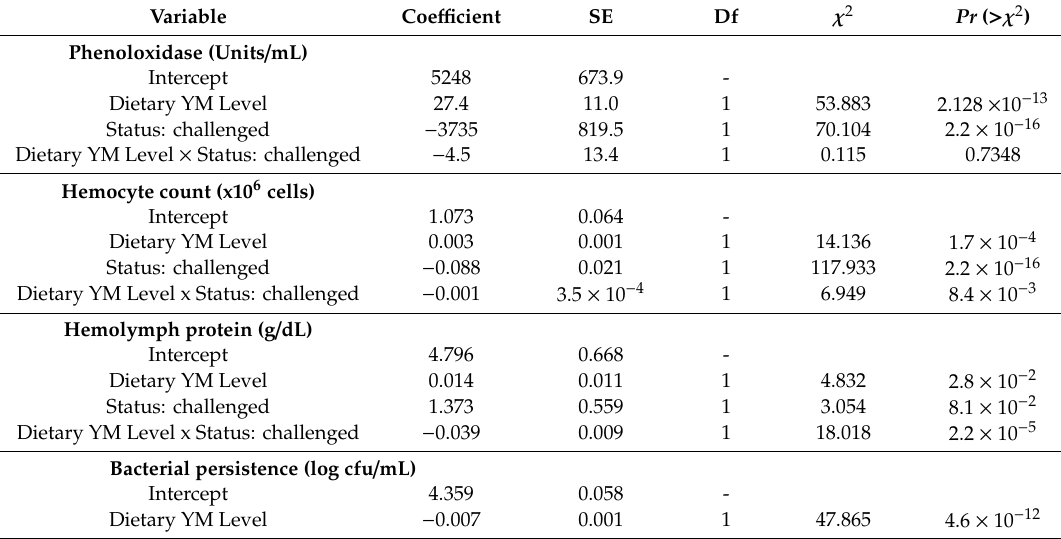
Table 5. Di ff erent immunological responses as a function of bacterial challenge status and dietary YM